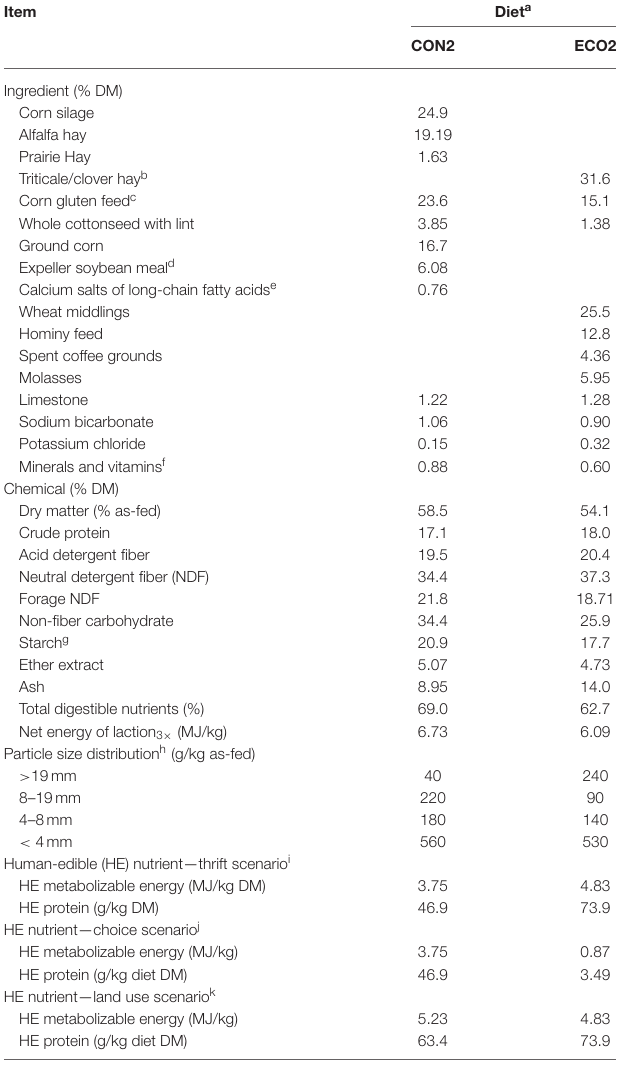
TABLE 3 | Ingredient, chemical composition, and particle size distribution of diets provided in Experiment 2. Item Diet